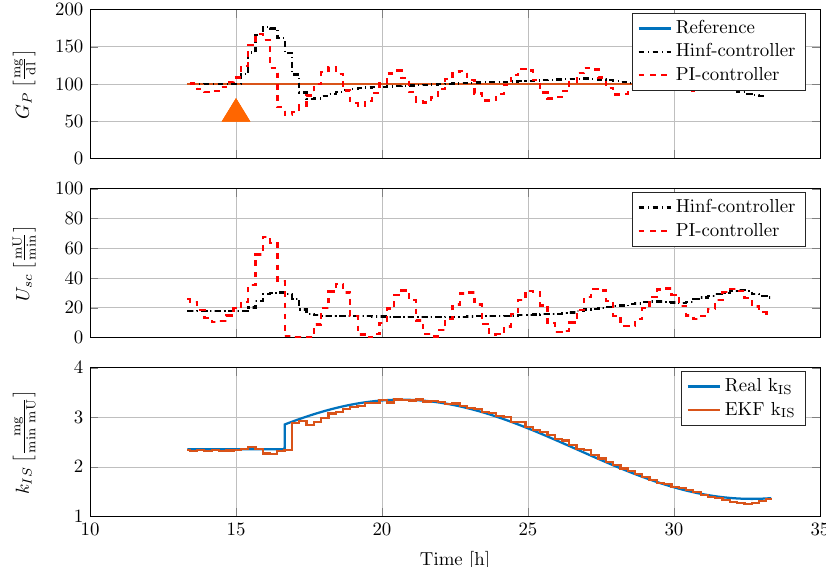
Figure 11. Comparison of controller disturbance rejection test with nonlinear minipig model #5 and time-varying insulin sensitivity k IS ( t ) . 50 mg carbohydrates (CHO) are given to the minipig at 15 h, indicated by an orange